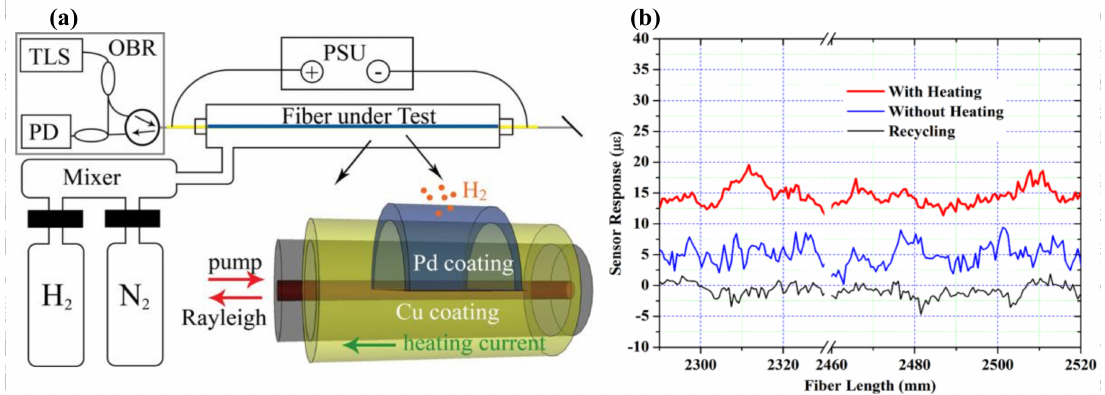
Figure 32. ( a ) Experimental setup of the distributed hydrogen sensing system using electrically heated optical fiber. OBR is optical backscatter reflectometer, namely OFDR. TLS is tunable laser source. PD is photo-detector. PSU is power supply. ( b ) The sensor strain response to hydrogen exposure at different positions on the same fiber (reprinted from Chen et al. [72]. with permission of AIP Publishing LLC; copyright